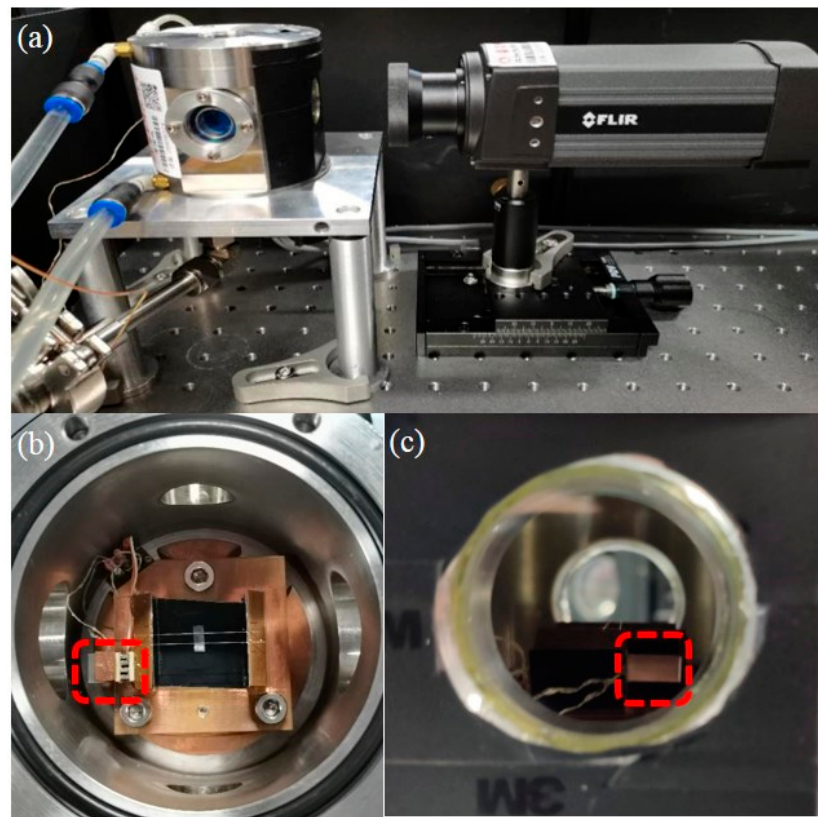
Figure 2. The photograph of the LITMoS test set-up and the thermal camera calibration. ( a ) The cooling grade testing chamber with the water chiller and the thermal camera (FIRE A300). ( b ) The interior of the cooling grade testing chamber (top view). The TEC and copper clam, including the reference sample (inside the area of the red dash box). ( c ) The interior of the cooling grade testing chamber (side view).